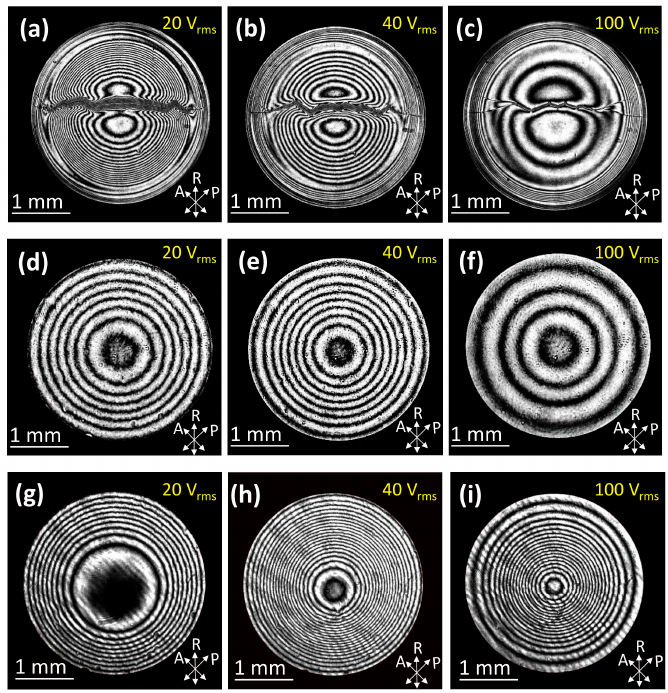
Figure 4. Quantitative comparisons of the interference patterns in LC lenses with different conditions: Conventional LC lens without an insulator layer at a voltage of ( a ) 20 V rms ( b ) 40 V rms , and ( c ) 100 V rms . Conventional LC lens with an insulator of 1.1 mm glass substrate at a voltage of ( d ) 20 V rms ( e ) 40 V rms , and ( f ) 100 V rms . TLCL lens at a voltage of ( g ) 20 V rms ( h ) 40 V rms , and ( i ) 100 V rms . The double-head arrows indicate the rubbing direction of the LC alignments indicated by R; the polarization directions of a pair of crossed polarizers are indicated by A and P.